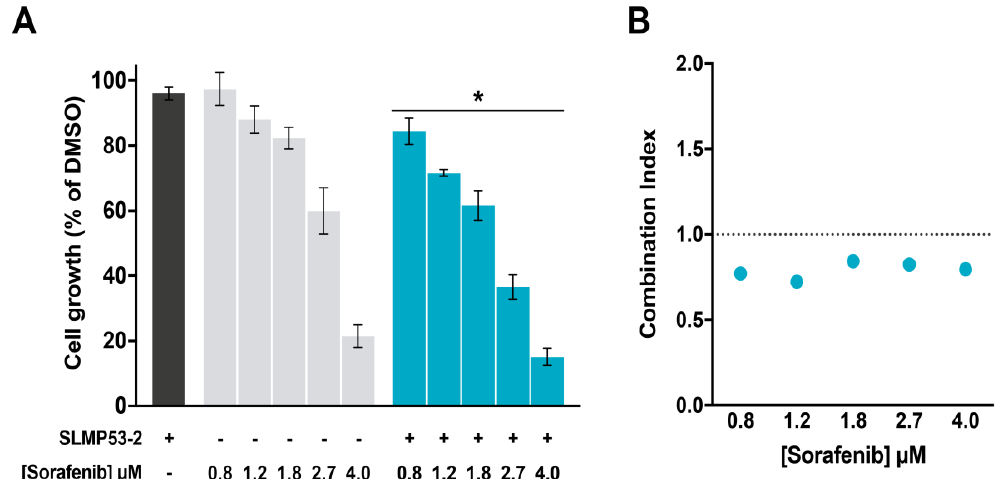
Figure 6. SLMP53-2 synergizes with sorafenib in HCC cells. HuH-7 cells were treated with increasing concentrations of sorafenib, alone and in combination with 1.5 µM SLMP53-2. ( A ) Cell growth was measured by SRB assay after 48 h treatment; growth obtained with control (DMSO) was set as 100%. Data are mean ± SEM ( n = 4); values significantly different from chemotherapeutic alone: * p < 0.05, two-way ANOVA. ( B ) Combination index (CI) values calculated using the CompuSyn software for each combined treatment. CI < 1, synergy; 1 < CI < 1.1, additive effect; CI > 1.1, antagonism. CI values were calculated using a mean value effect ( n = 4).